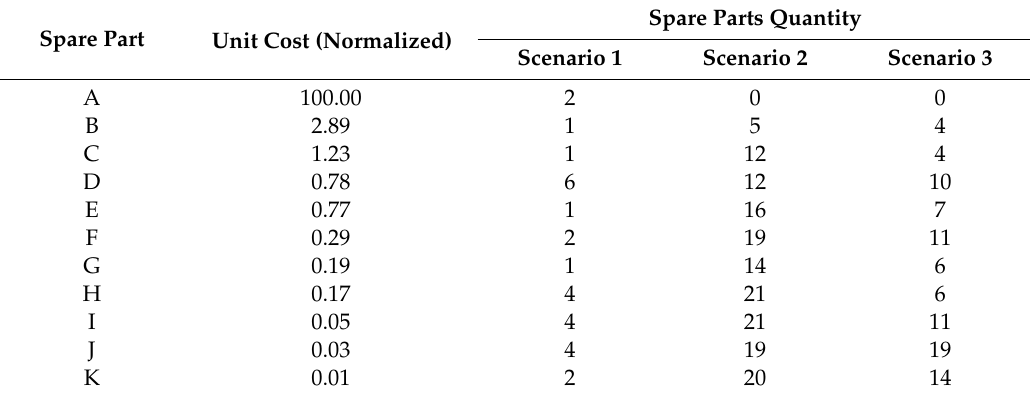
Table 5. Partial list of spare parts and their quantities in the optimized field repair kit for each